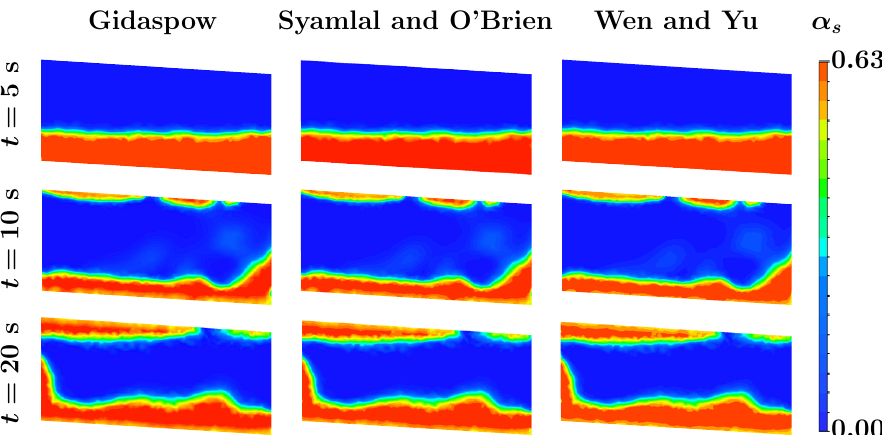
Figure 7. Front view of a middle transversal plane of particle axial distribution with different drag models at different simulation times with a 30% fill rate α s (particle volume fraction), a domain rotational speed of 8 rpm, and an inclination of 3.57 ◦ .